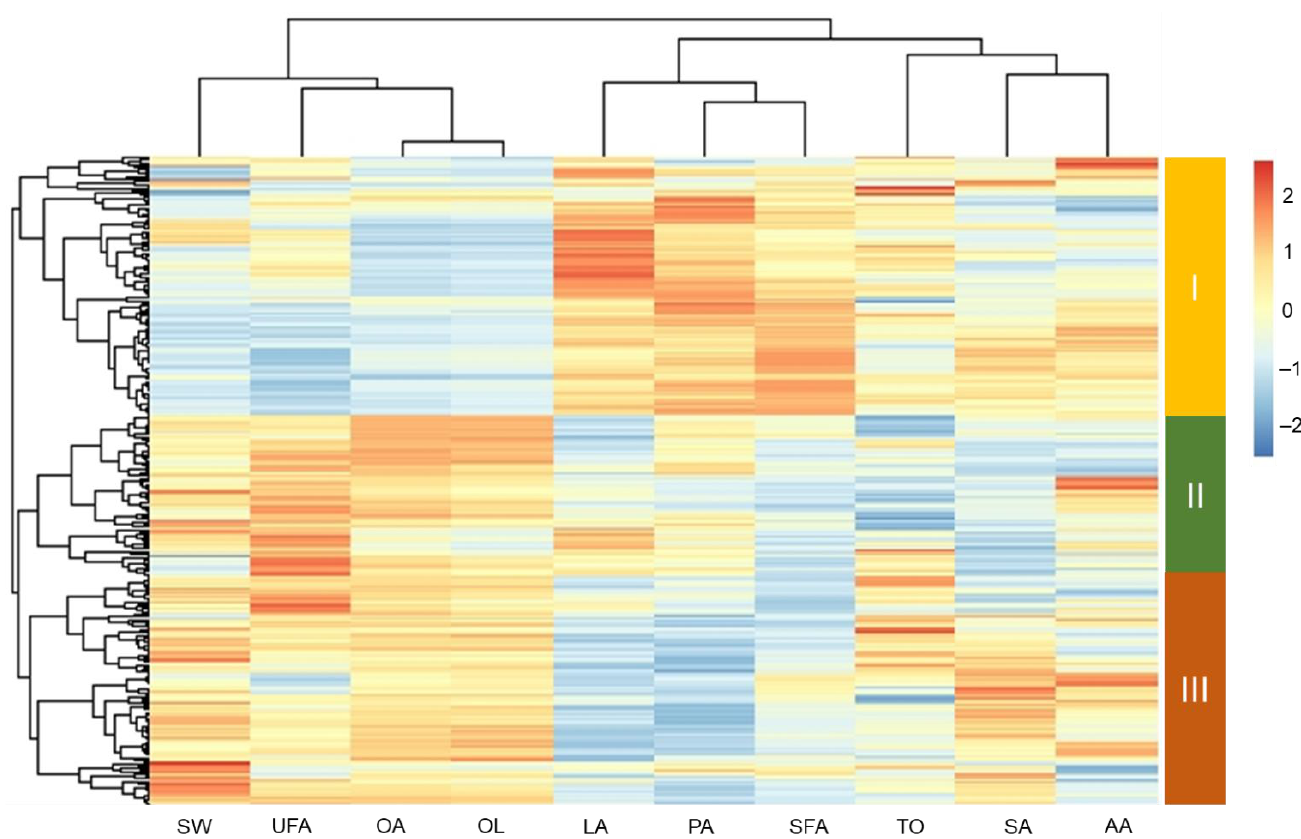
Figure 3. Hierarchical cluster analysis of seed weight, total oil content, and individual and total fatty acid contents using the whole dataset. SW = 100-seed weight, TO = total oil, PA = palmitic acid, SA = stearic acid, OA = oleic acid, LA = linoleic acid, AA = arachidic acid, OL = oleic acid to linoleic acid ratio, SFA = total saturated fatty acid, UFA = total unsaturated fatty acid.